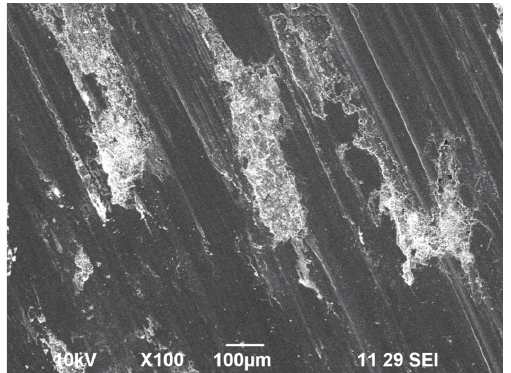
Figure 5: Worn surface of red mud reinforced aluminium matrix at 30 N and